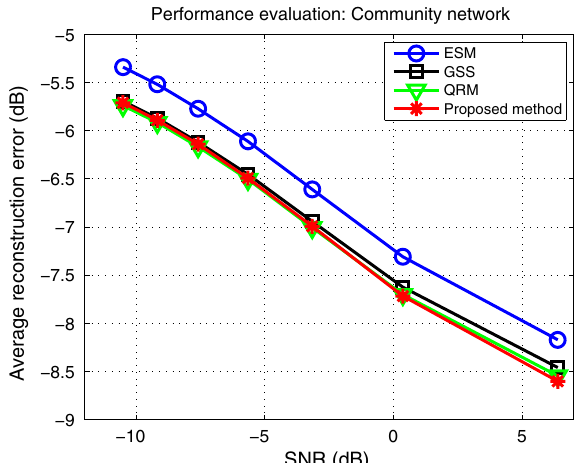
Fig. 10 Performance evaluation for noisy non‑bandlimited graph signals on CNG with | S | = 50 by varying SNR